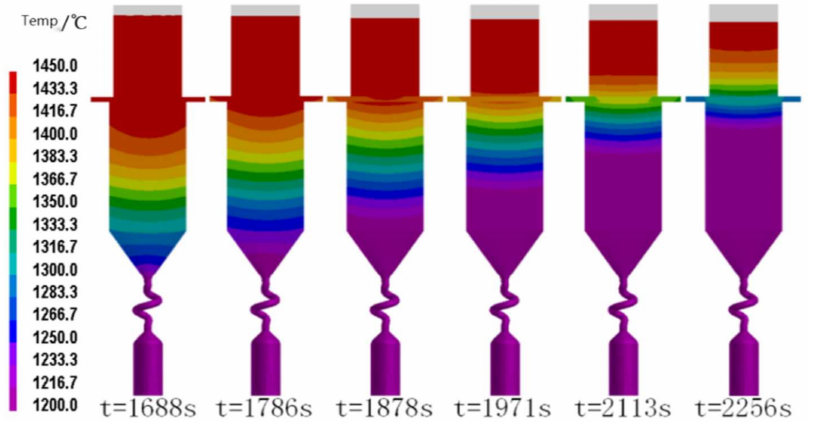
Figure 10. Temperature field at different times with equal wall thickness